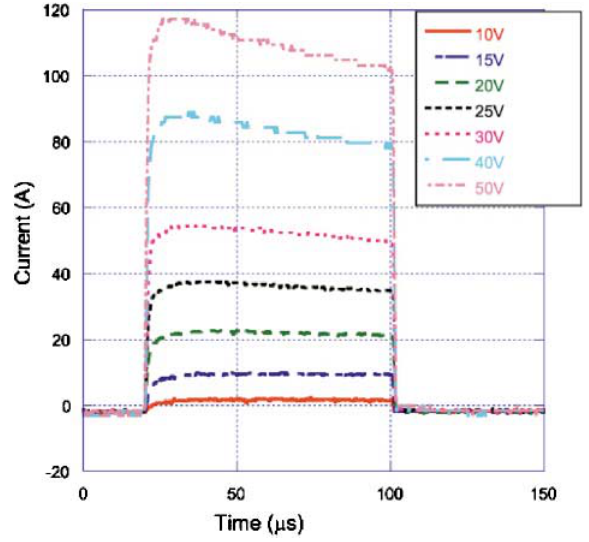
FIG. 17. (Color) Current with various forward bias voltages. FIG. 18. (Color) The recovery from forward bias to reverse